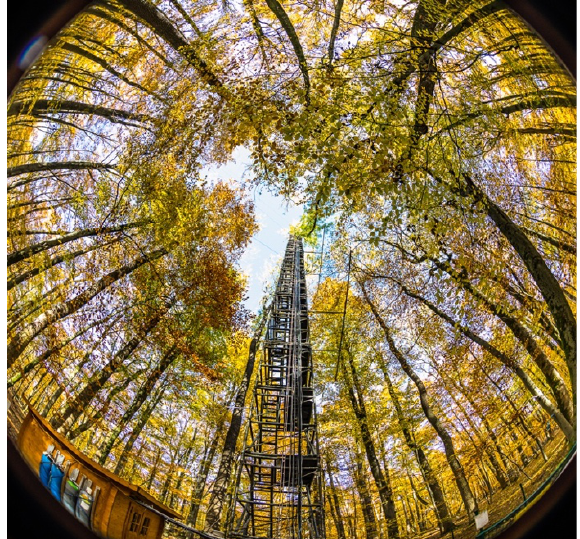
Figure 1: Flux tower installation in the Hainich national park area photographed in November 2018 from the forest ground level